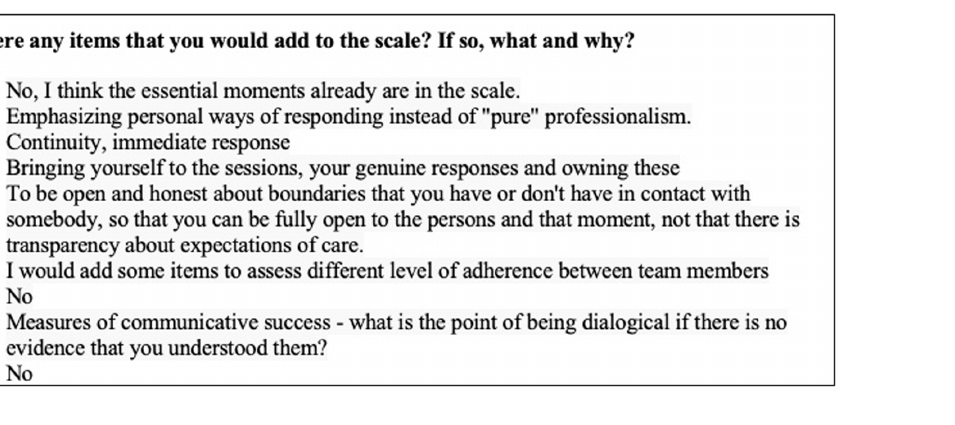
FIGURE 2 Items to add to the